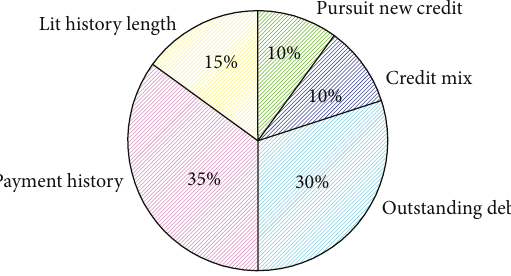
Figure 1: Reference elements of the traditional credit scoring